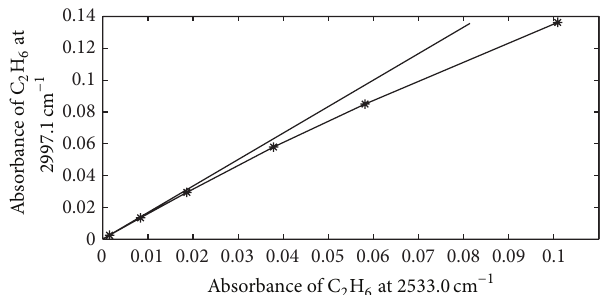
Figure 2: Absorbance of C 2 H 6 at 2933.0 cm −1 versus that at 2997.1 cm −1 .